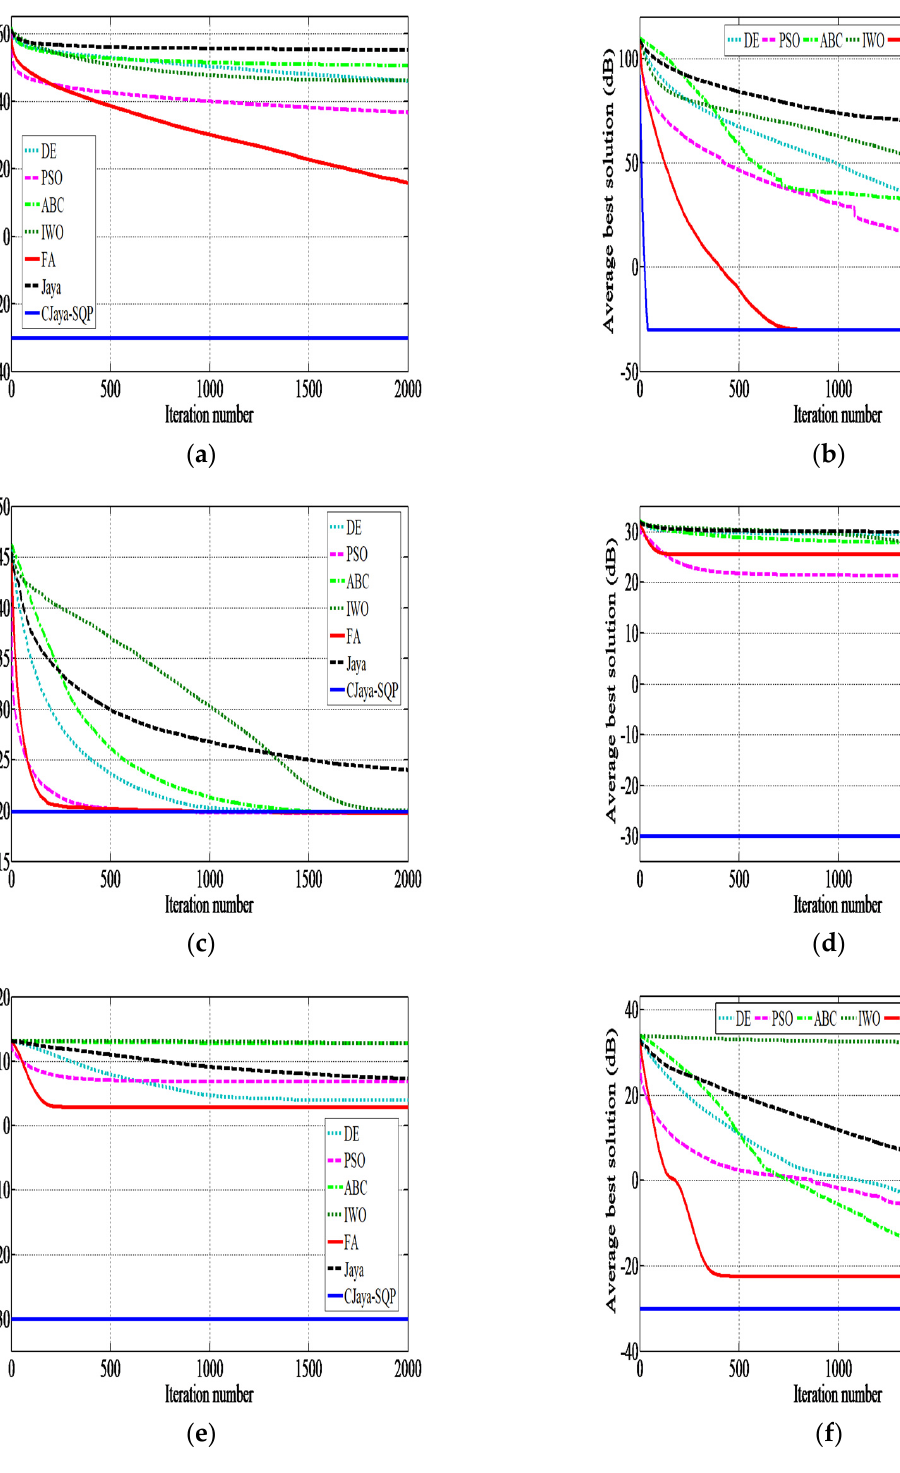
Figure 14. Convergence characteristics of comparative algorithms on the 100-dimensional rotated functions: ( a ) f 10 Rotated Schwefel 1.2; ( b ) f 12 Rotated Zakharov; ( c ) f 13 Rotated Rosenbrock; ( d ) f 14 Rotated Rastrigin; ( e ) f 16 Rotated Ackley; and ( f ) f 17 Rotated Griewank.